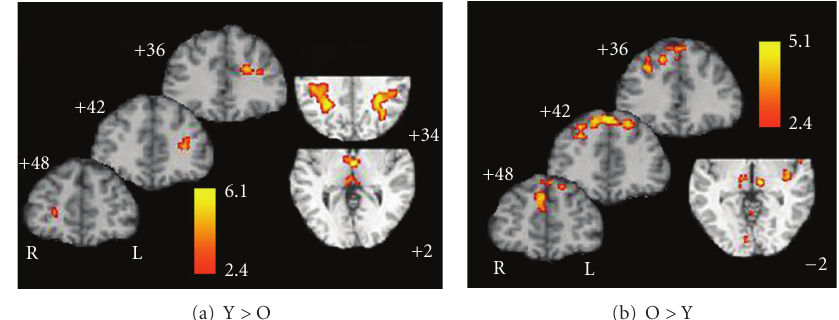
Figure 7: Regions of activation that were di ff erentially greater for younger (a) relative to older adults and those that were di ff erentially greater for older compared to younger adults (b) on the 2-back task.